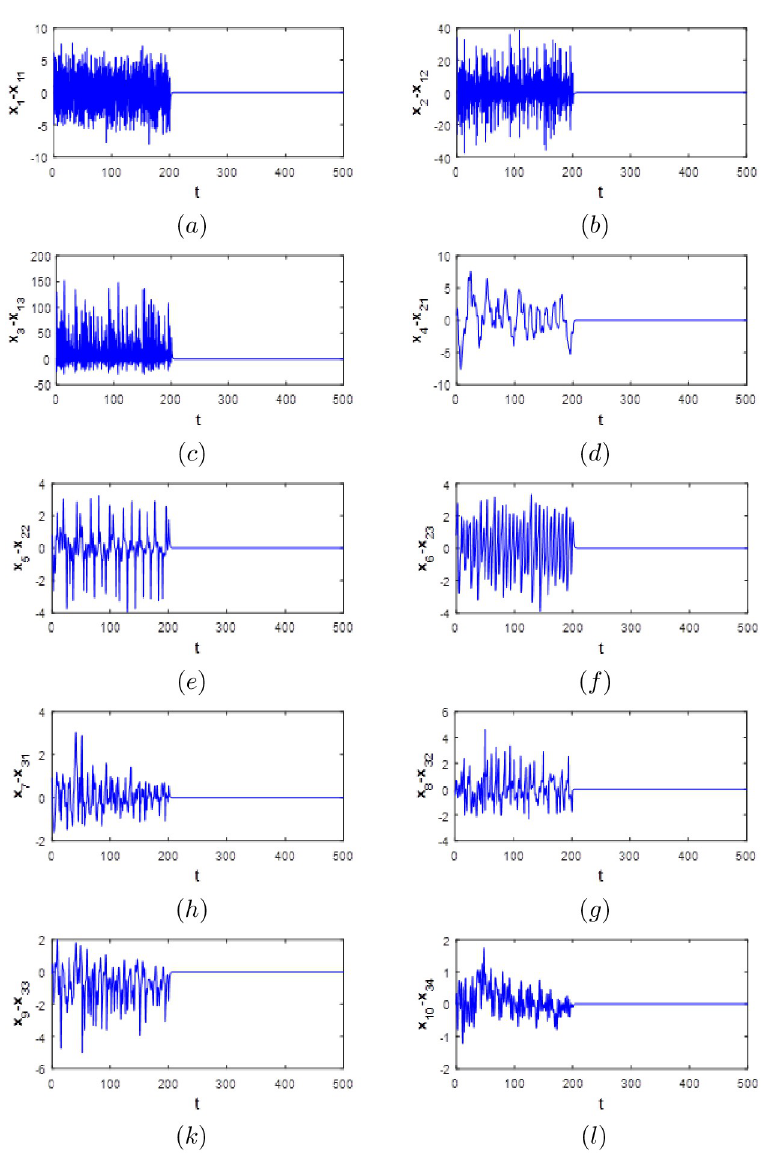
Fig 20. Time evolution of the synchronization errors with controllers deactivated ( t < 200 s ) and activated ( t > 200 s ).